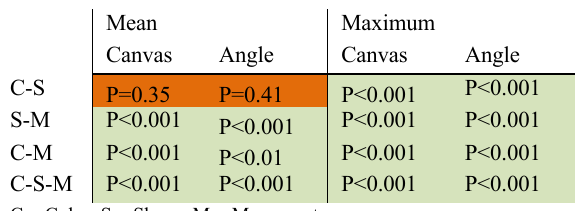
Figure 16: Recognition rate of the three